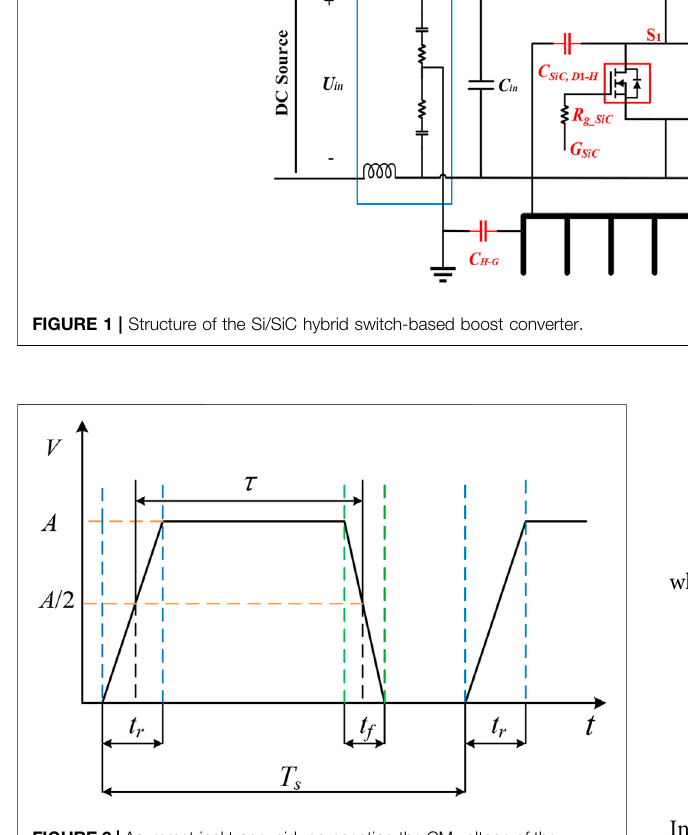
Fourier coef fi cient in the asymmetrical trapezoidal waveform is written as (Igarashi et al., 2007; Qi et al., 2010; Han et al., 2017b; Fang et al., 2018).